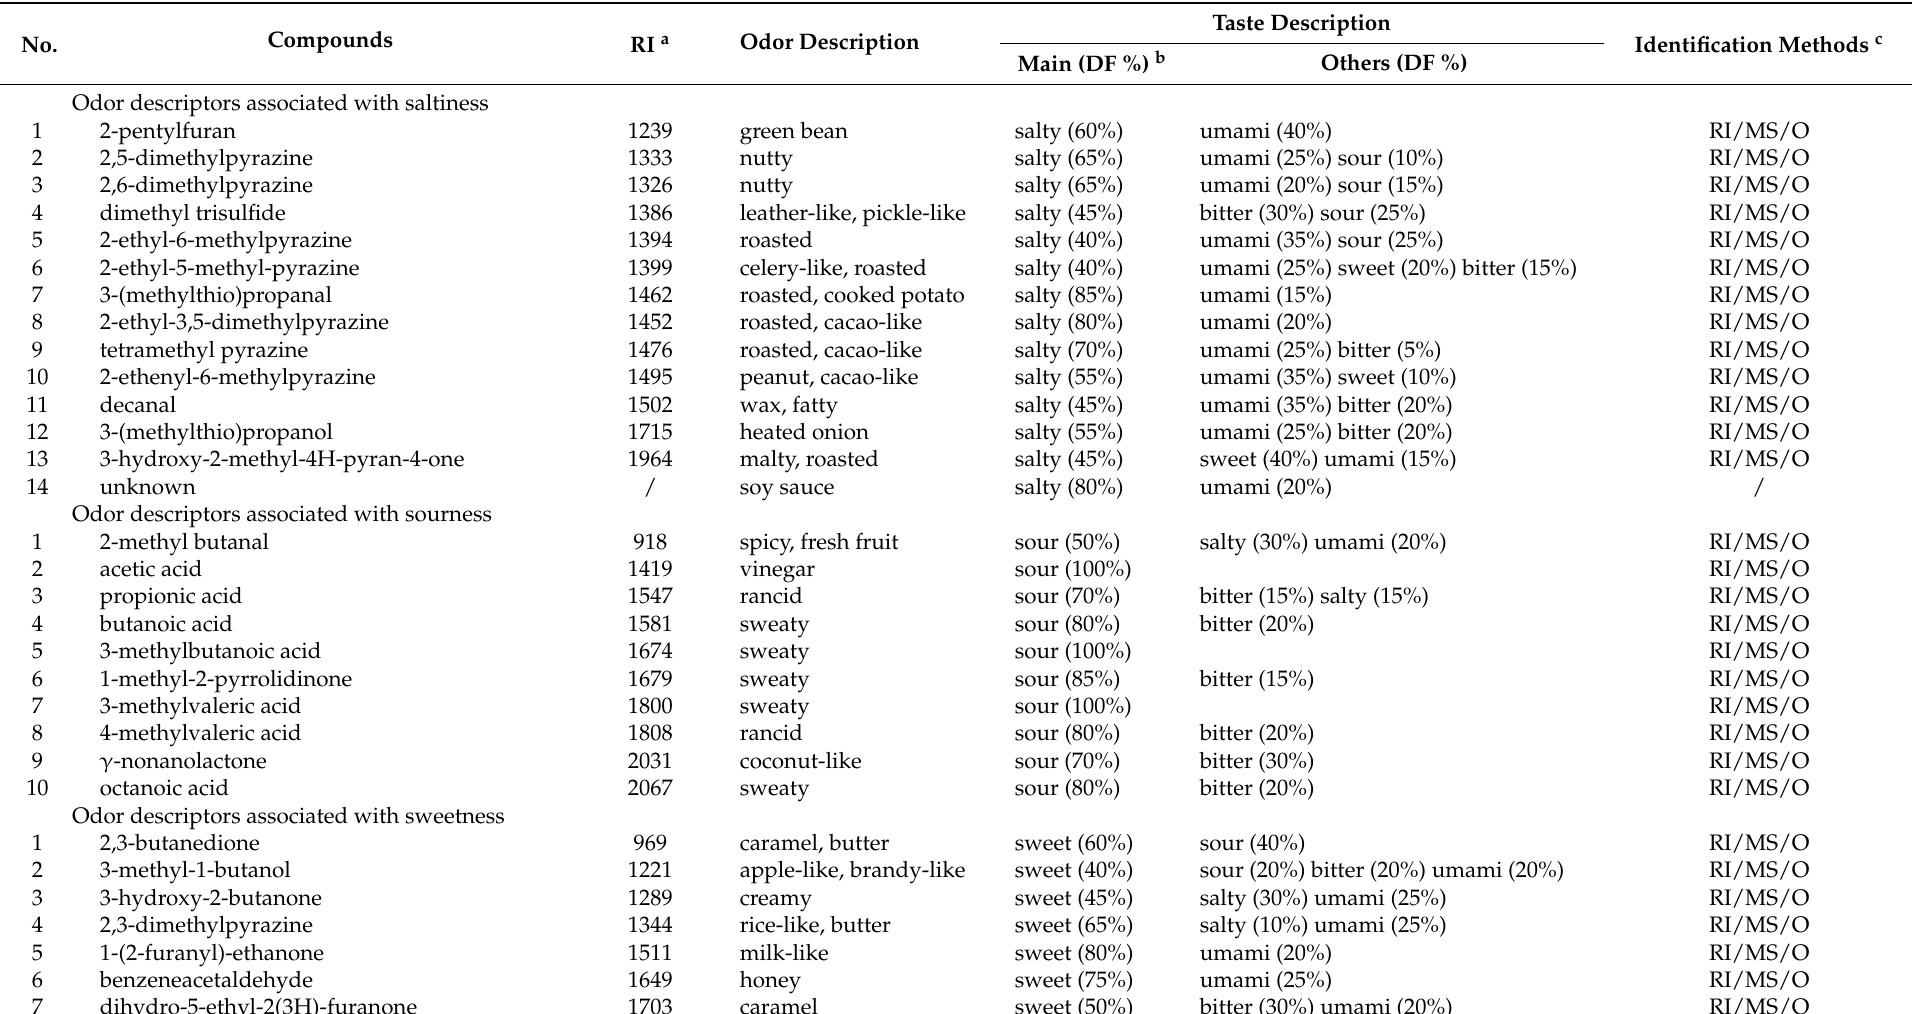
Table 1. Odorants identified in Yongchuan Douchi by gas chromatography − mass spectrometry and gas chromatography-olfactometry/associated